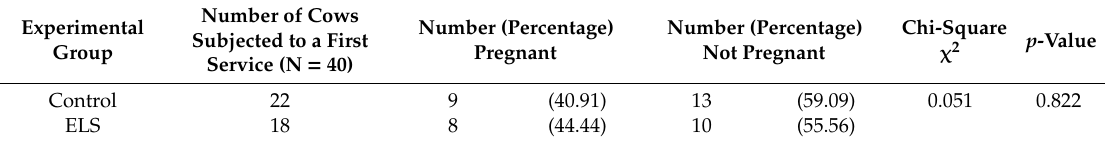
Experimental Group